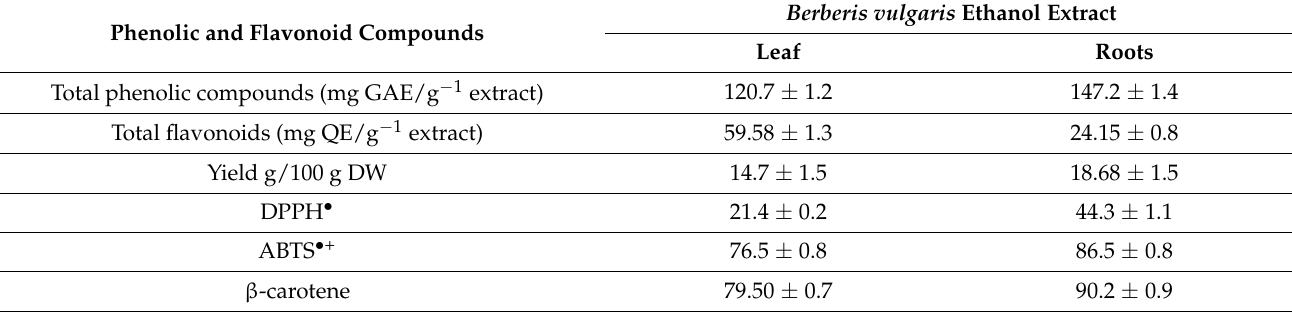
Table 1. Yield extract and polyphenol compounds in Berberis vulgaris leaf and roots extracts. Phenolic and Flavonoid